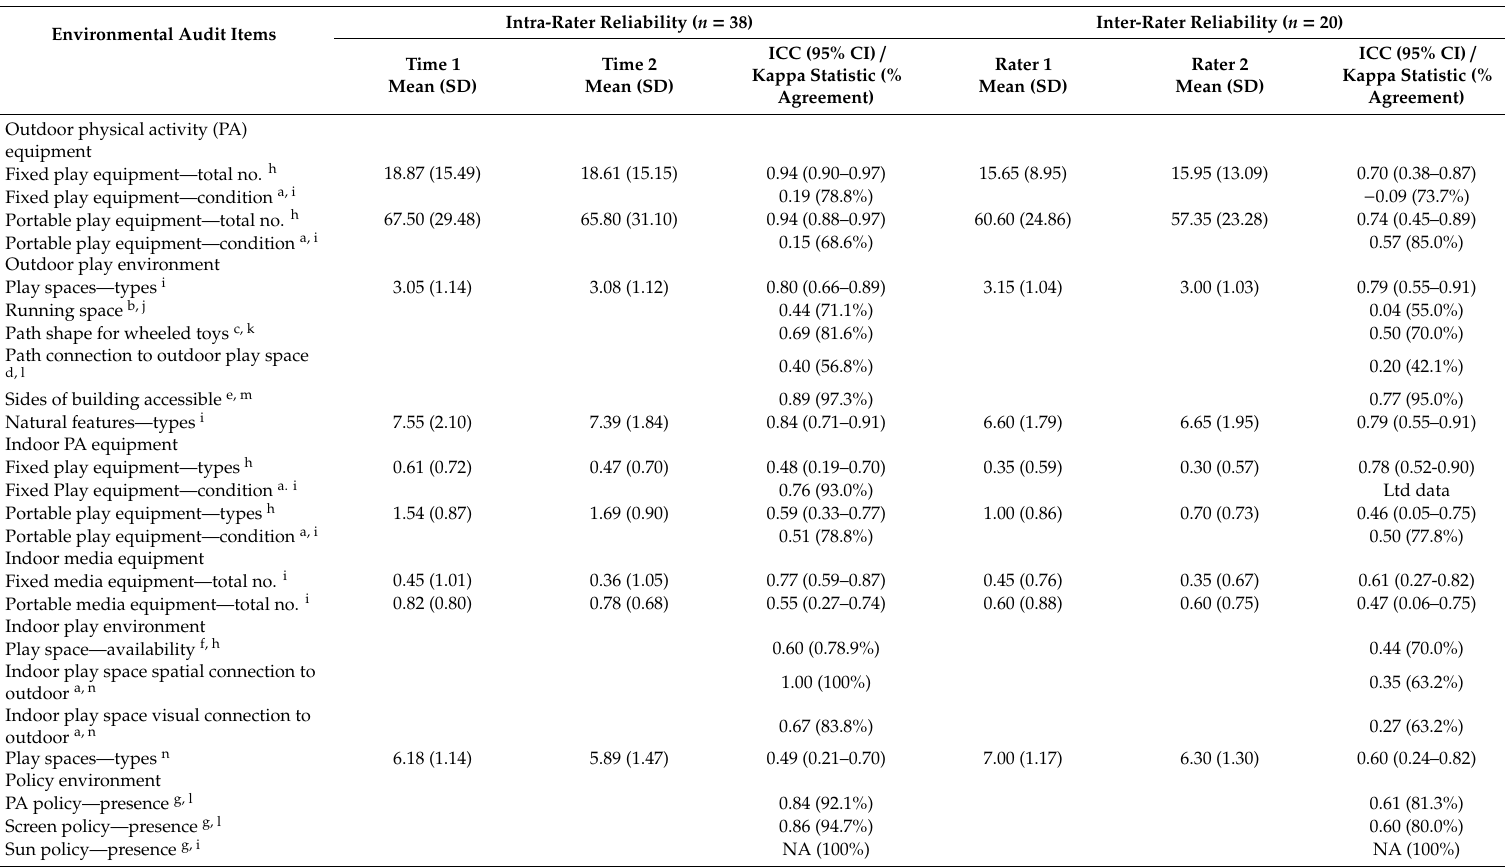
Table 1. Intra—and inter-rater reliability results for the early childhood education and care (ECEC) environmental audit. Environmental Audit